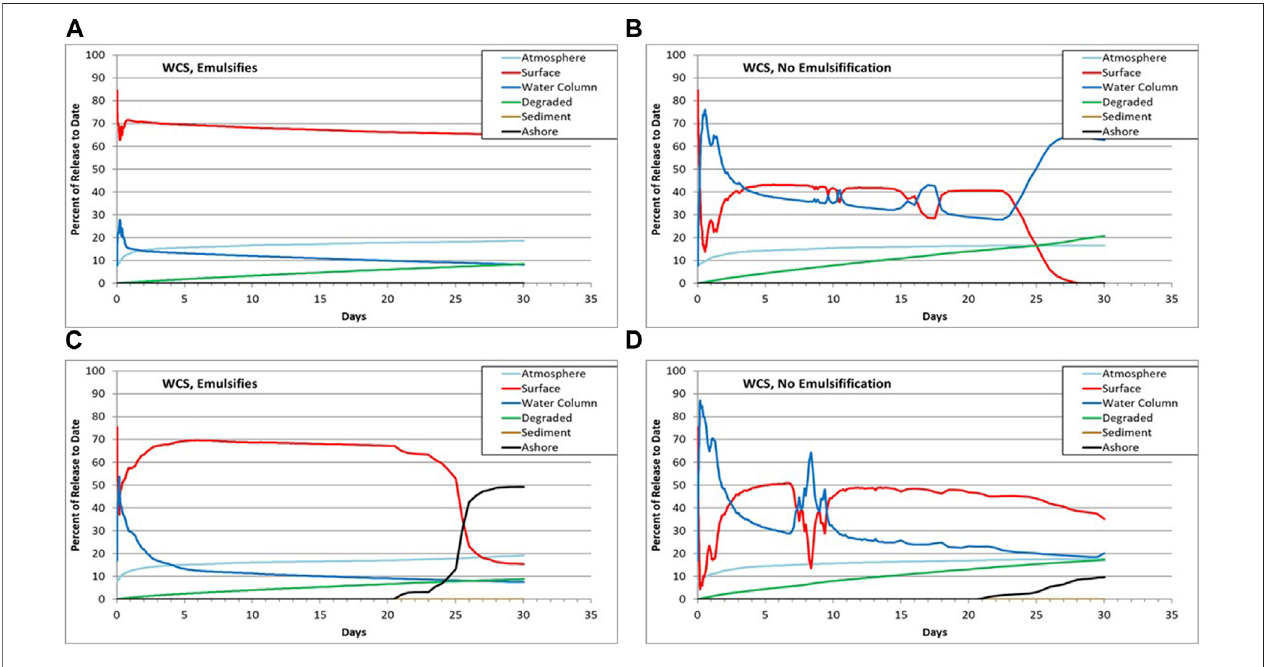
FIGURE8| Massbalance(aspercentofthespilledmass)forasurfacereleaseof200 MTofWCSfortherunsthatledtothe95thpercentileforsurfaceoilexposure [ (A,B) ; 15 August 2008] and for water column exposure [ (C,D) ; 15 May 2008], including emulsi fi cation (A,C) and not including emulsi fi cation (B,D) .